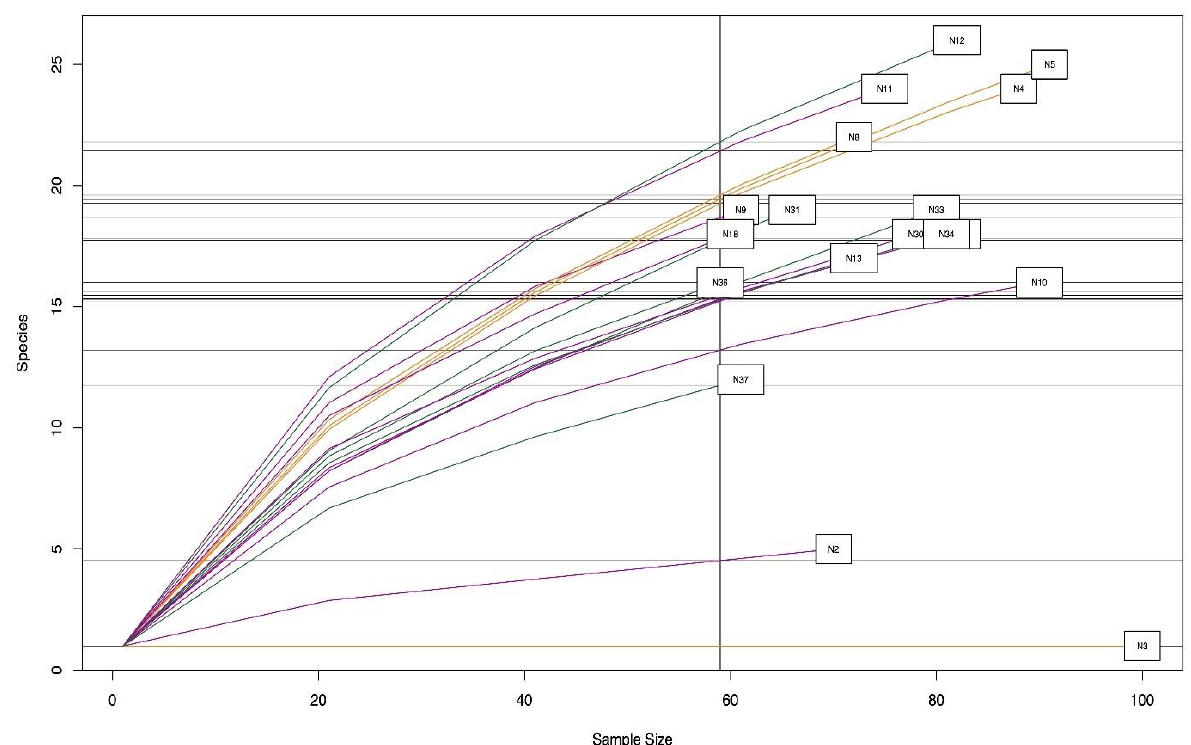
Figure 3. Species accumulation curve in fecal samples. The samples showed asymptomatic behavior leading to similar diversity between samples except for sample N3.